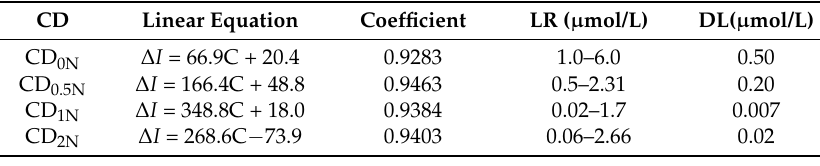
Table 2. Analytical features of CD-catalytic SERS determination of sulfate.